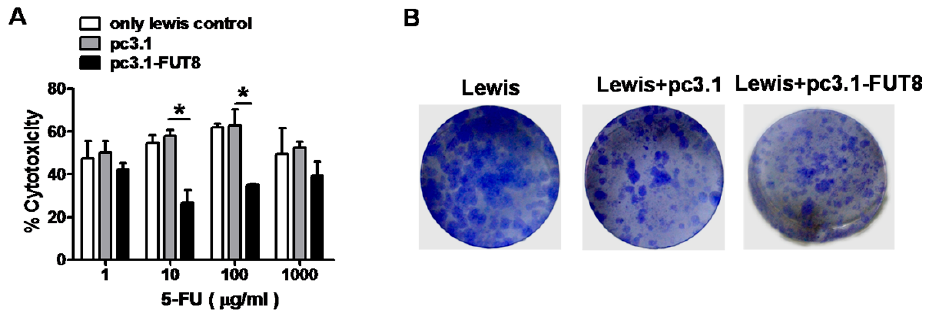
Figure 10. Overexpression of FUT8 enhanced the chemo-resistance of Lewis cells. ( A ) LDH assay of the e ff ect of overexpression of FUT8 on the chemo-resistance to 5-FU in Lewis cells. * p < 0.05, pc3.1-FUT8-treated group vs lewis / pc3.1 groups. ( B ) The colony formation assay of the e ff ect of overexpression of FUT8 in Lewis